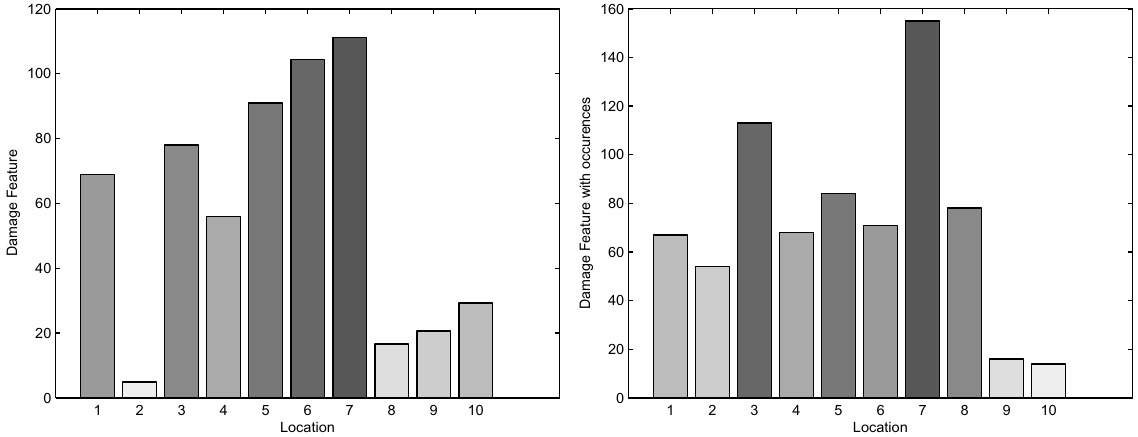
Fig. 30. Damage feature without and with occurrences for damaged structure and constant loading conditions (force applied in DOF 1), frequency range 10–100 Hz.